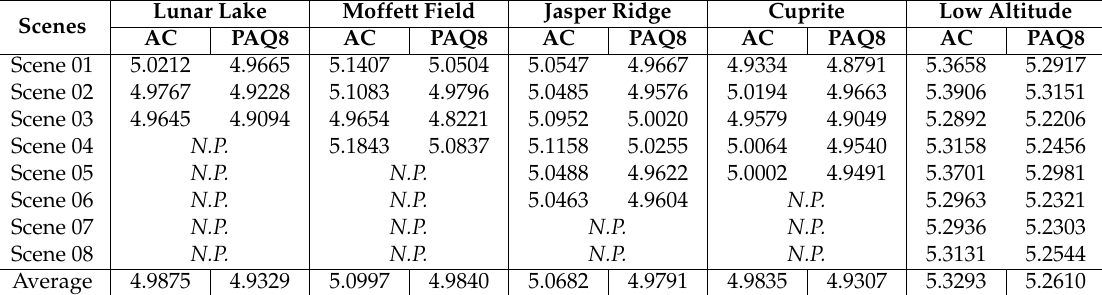
Table 3. Achieved results by using the following parameters: N “ 16, B “ 1.